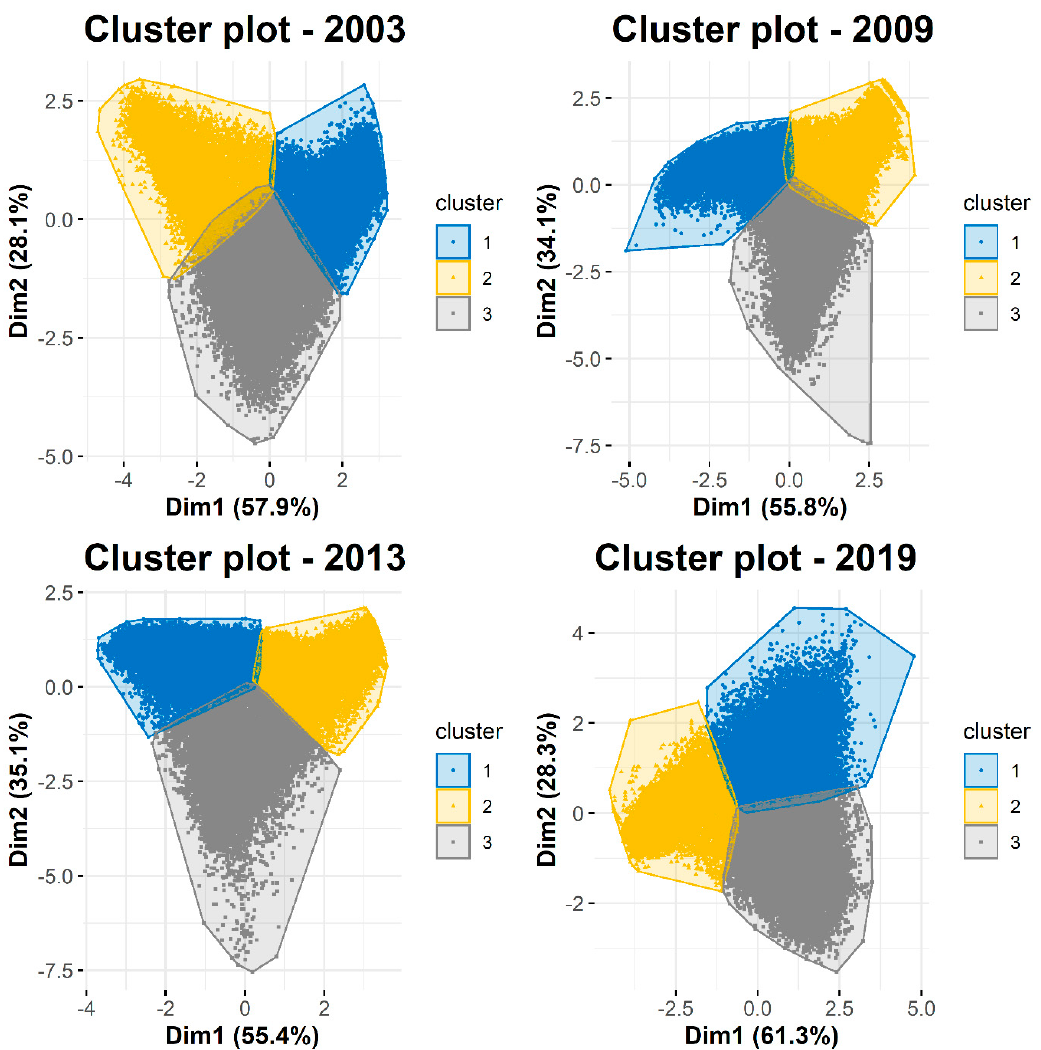
Figure 4. Illustration of the clustering results of the years of 2003, 2009, 2013, and 2019 produced by the CLARA algorithm. The clusters are well separated by the first two PCA (principle component analysis) axes (Dim1 and Dim2), which account for 86.0%, 89.9%, 90.5%, and 89.6% of the variations in observations for 2003, 2009, 2013, and 2019, respectively.